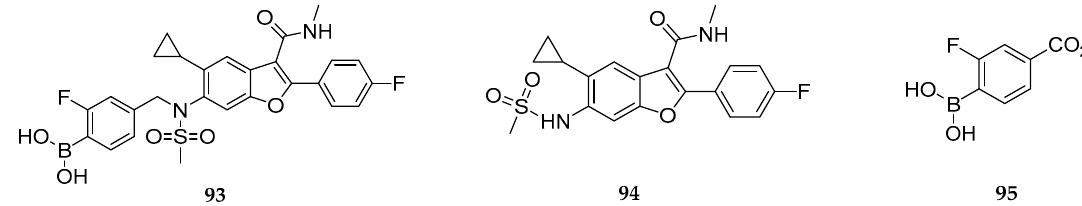
Figure 9. NS5B polymerase inhibitor for HCV treatment ( 93 ) and its metabolites ( 94 and 95 ).